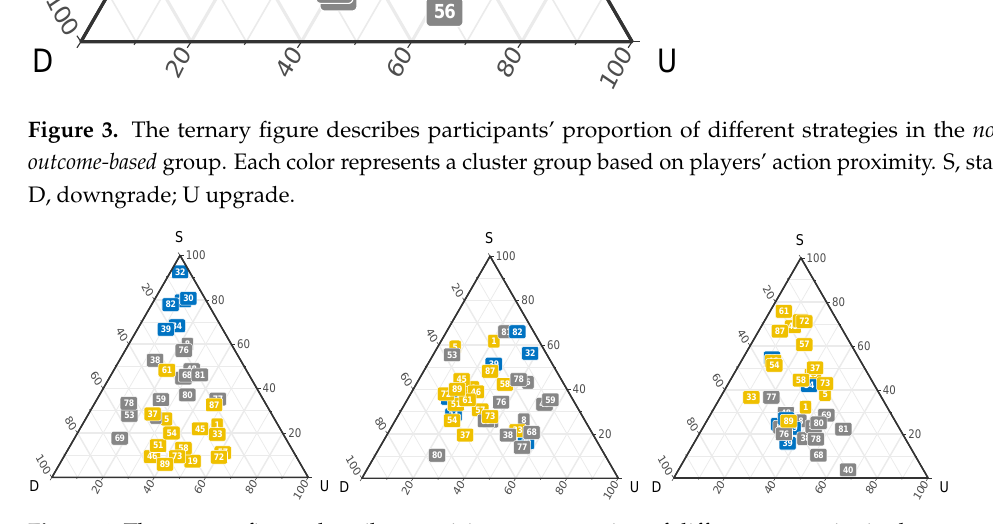
Figure 4. The ternary figure describes participants proportion of different strategies in the outcome- based group separately by the outcome: win ( left ); tie ( middle ); and lose ( right ). Each color represents a cluster group based on players’ action proximity. S, stay; D, downgrade; U,